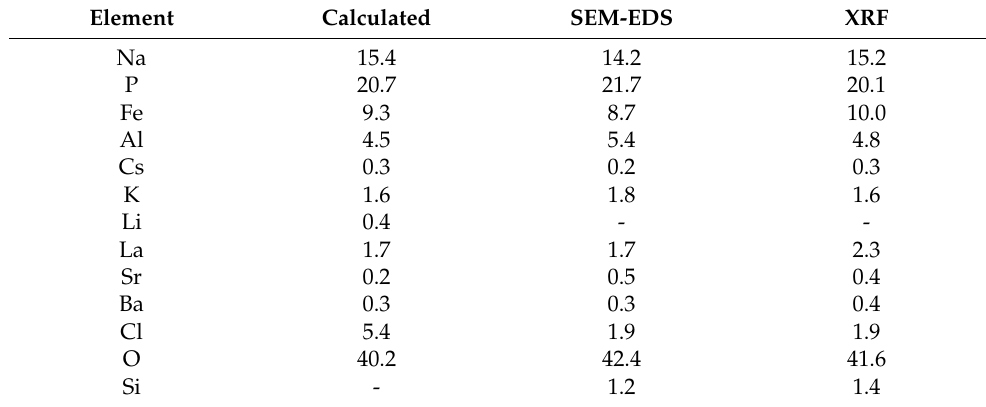
Table 2. The elemental composition (wt%) of NAFP glass samples containing spent electrolyte imitator. Element